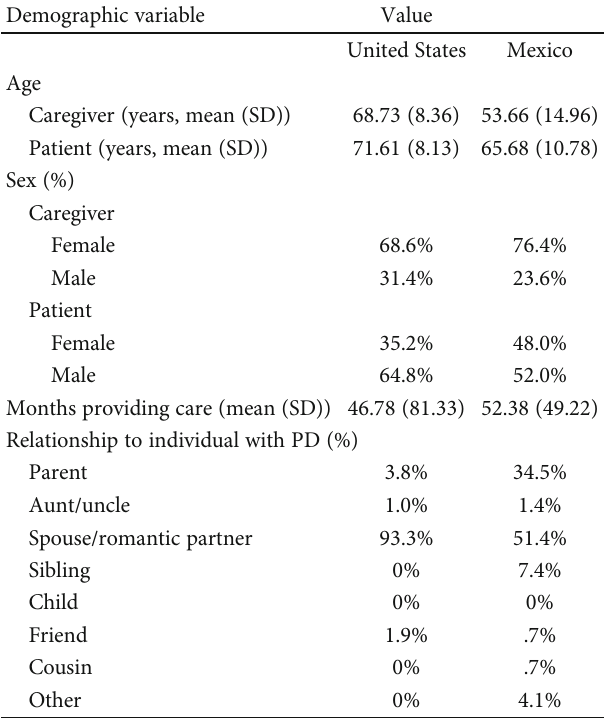
Table 1: Characteristics of PD caregivers and